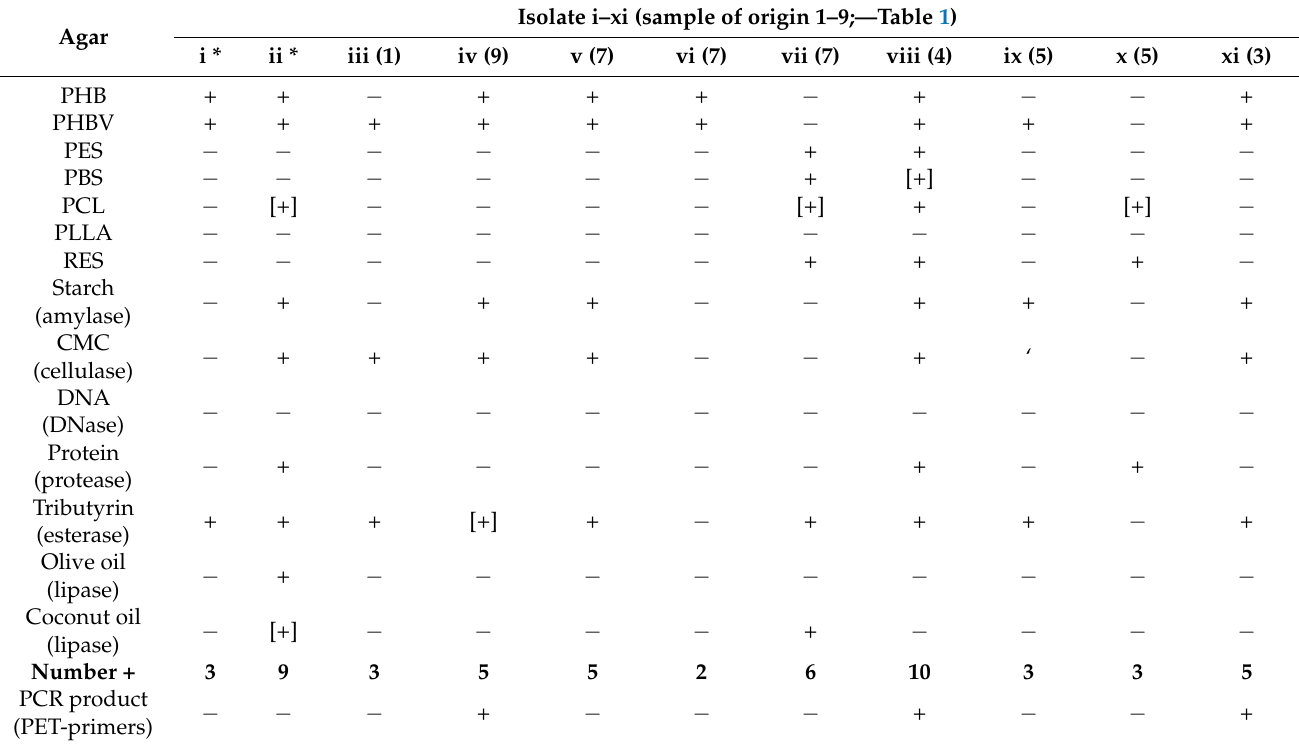
Table 3 gives a detailed presentation of the sequencing-based identifications of the 11 isolates based on similarity searches of partial 16S rDNA gene